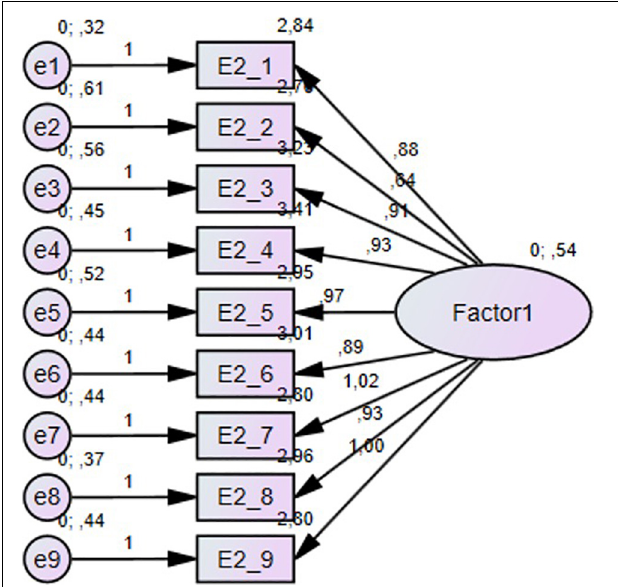
FIGURE 2 | Model of CFA for the Employability